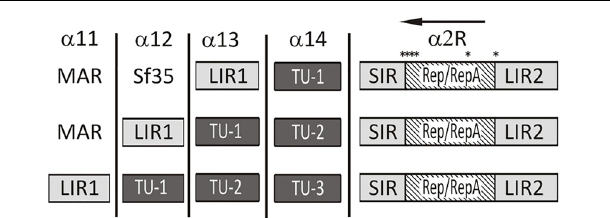
FIGURE 2 | Schematic representation of possible assemblies of GB vectors with BeYDV elements. The mutations inserted into complementary part of BeYDV genome are symbolized by an asterisk. The design allows the insertion of up-to 3 transcriptional units (TU) in one replicon in a single assembly reaction. Stuffer fragment (Sf35) is a short 35bp